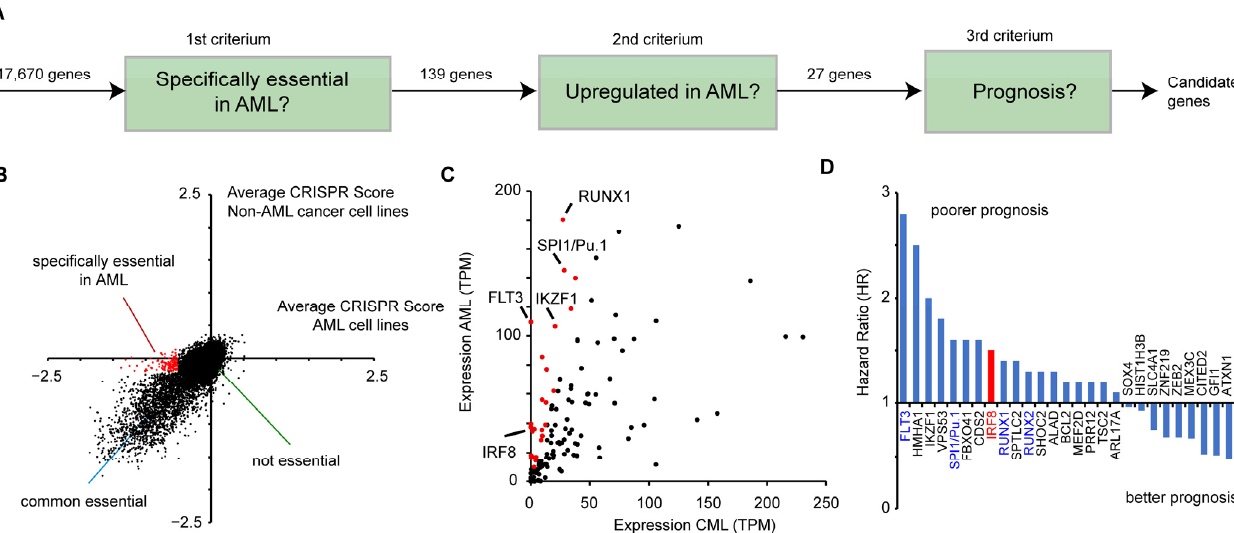
Figure 1. Identification of IRF8 as an acute myeloid leukemia (AML)-specific susceptibility gene. ( A ) Schematic representation of the selection process to identify potential candidates that play a role in AML. ( B ) Comparison of CRISPR scores of AML and non-AML cell lines [45] . Genes in red ( n = 139), have an average CRISPR score below − 0.5 in the AML cell lines, and a score above − 0.2 in non-AML cell lines. See also Table S2. ( C ) Comparison of the gene expression of the 139 genes from ( B ) in AML and CML (“normal tissue”) samples, obtained from GEPIA. Red marked genes ( n = 27) have an at least 3-fold increased expression in AML cells compared to the control. ( D ) Hazard ratio (HR) comparing the 25% highest and lowest expressing AML samples of the 27 selected genes from ( C ). Data for ( C ) and ( D ) were derived from GEPIA [46] .